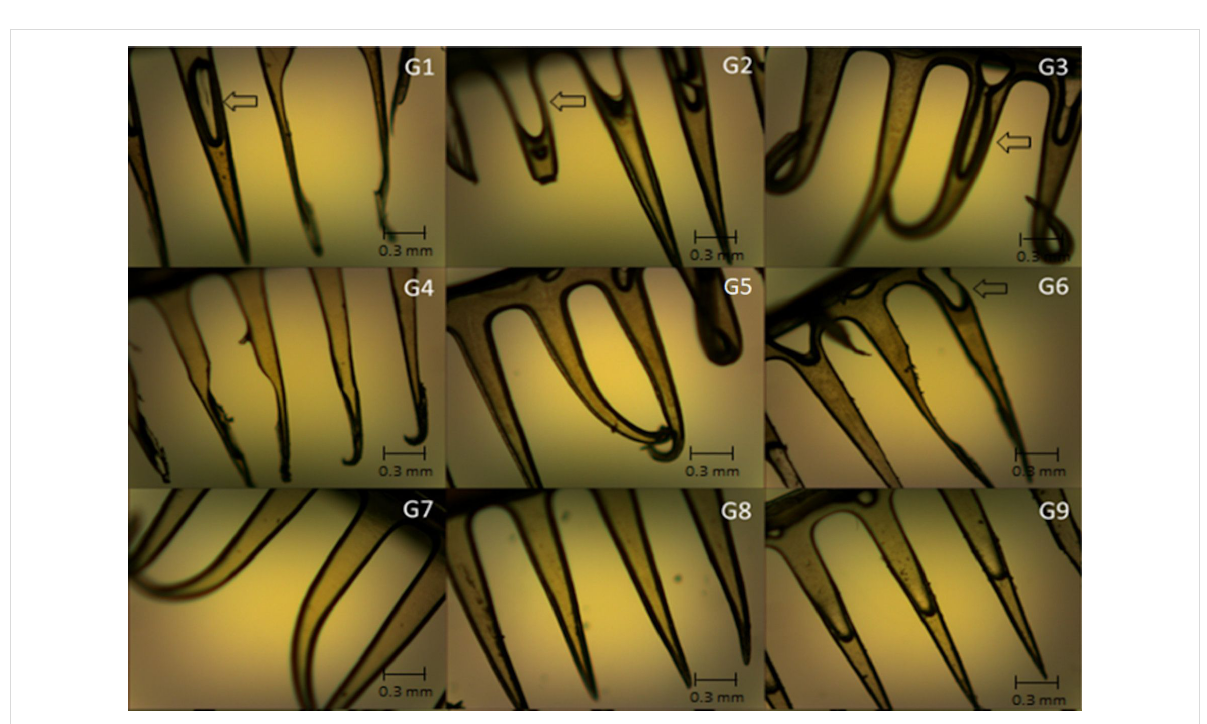
Figure 2: Micrographs obtained by optical microscopy showing the structure of microneedles containing glycolic extract of propolis (G1 to G9); magni- fication 40×. Arrows represent locations where bubbles are